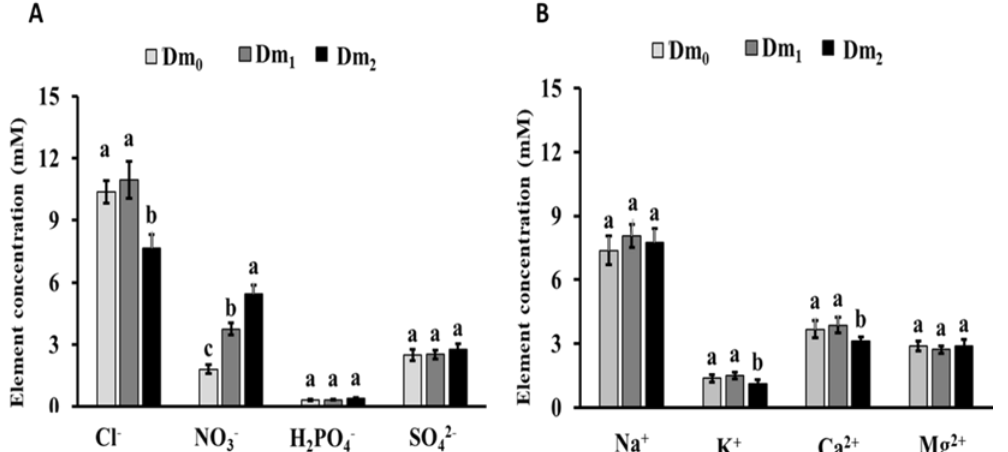
Figure 2. Anion ( A ) and cation ( B ) concentrations in the substrate at the end of the experimental period under the different fertigation treatments (Dm 0 —standard nutrient solution, Dm 1 —raw leachate treatment, and Dm 2 —raw leachate blended with H 2 O 2 treatment). Treatments with the same letters are not significantly different at p < 0.05 (ANOVA and LSD test). Data are the means ± standard deviation of four plants per treatment.